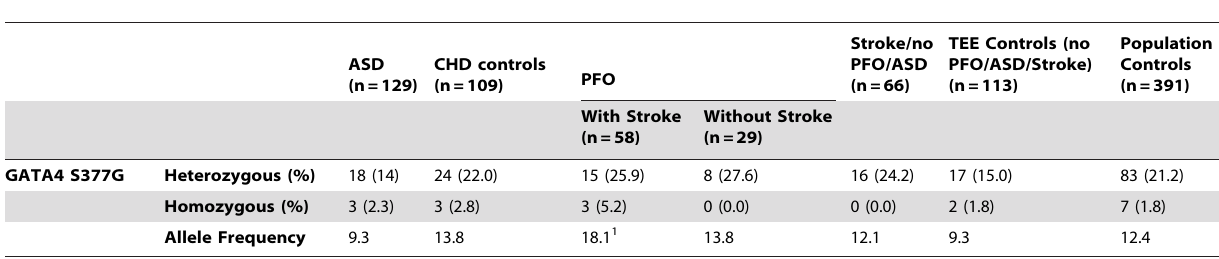
Table 3. GATA4 genotypes of Australian